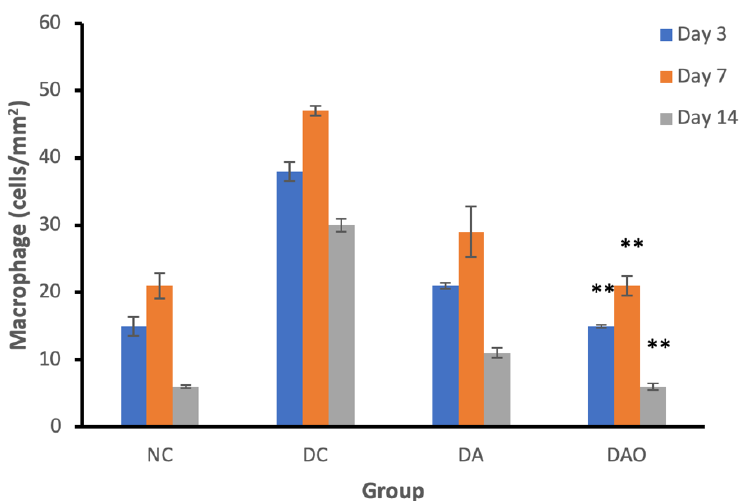
Figure 7. Graph of the number of macrophages. Notation on the graph shows the result of the statistical test (α < 0.05). (**) notation shows insignificant differences with NC, but significant differences with DC. ** = α ≤ 0.01 . NC—normal control group; DC—diabetic control group; DA—alginate treatment group; DAO—treatment of alginate–okra fruit extracts. All groups have three variation times.